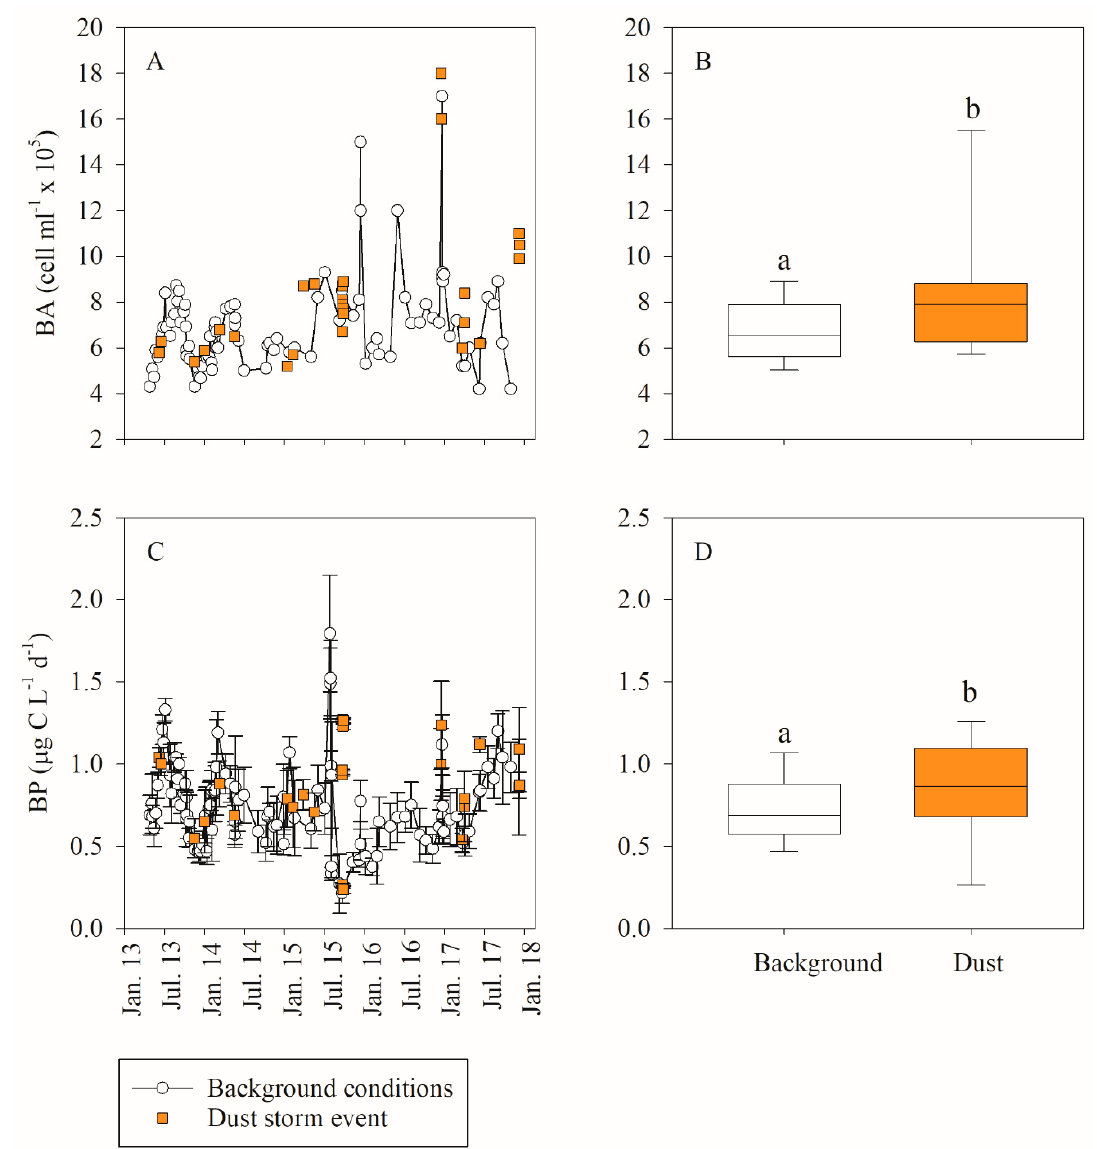
Figure 3. Surface (1–2 m) ( A , B ) bacterial abundance (BA) temporal variability and distribution and ( C , D ) bacterial production (BP) variability and distribution, respectively, at the coastal SEMS, 2013–2017. Measurements were taken during “typical” days (white, Supplementary Table S1, n = 89) and during dust storms (orange, Supplementary Table S2, n = 29). Box-whisker plots show interquartile range (25th to 75th percentile) of the dataset. Horizontal lines within the box represent median value. Letters above the box-plots represent significant differences ( t -test, p < 0.05) for mean values between background and dust measurements.